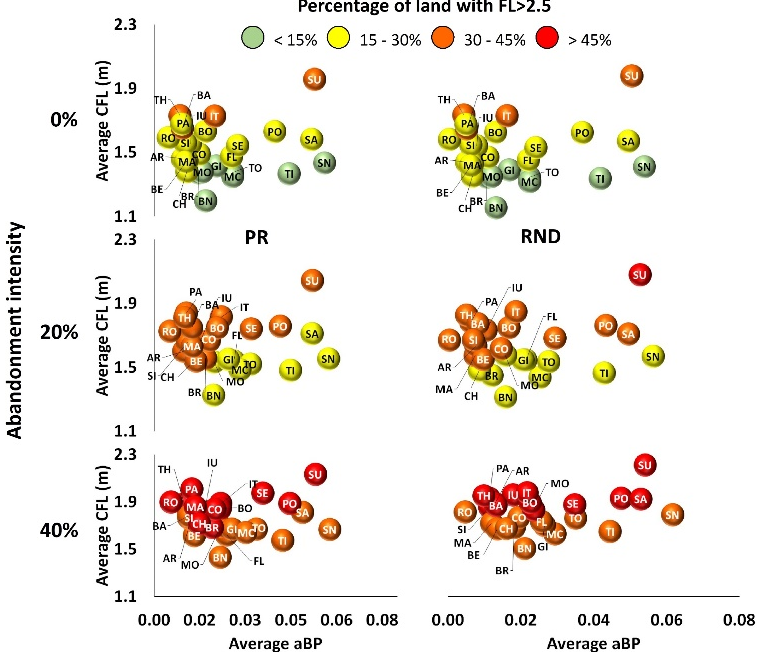
Figure 9. Scatterplots of annual burn probability (aBP) vs. conditional flame length (CFL (m)) at the municipality level for the NA conditions and two spatial patterns of land abandonment scenarios (priority (PR) and random (RND)), considering 20 and 40% of agropastoral land abandonment. The color of the bubbles is related to the percentage of municipal land with FL > 2.5 m. Municipality abbreviations are provided in Figure 1.